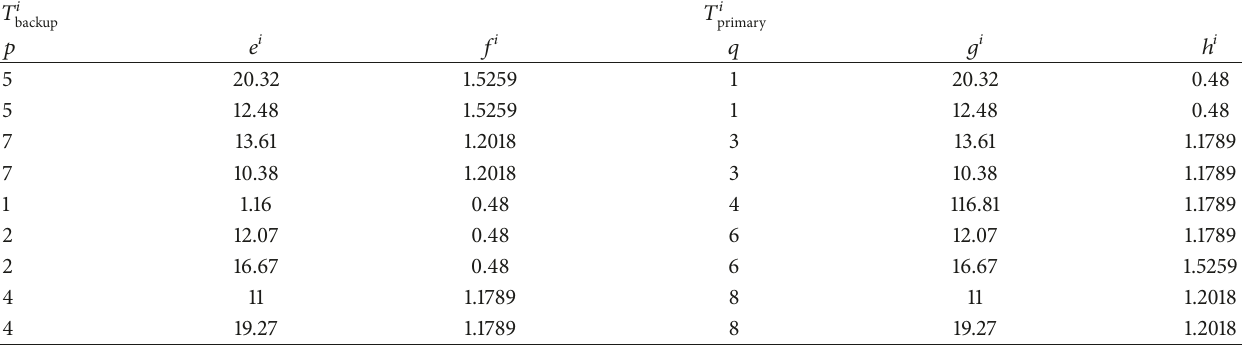
Table 10: Values of constants 𝑒 𝑖 , 𝑓 𝑖 ,𝑔 𝑖 , and ℎ 𝑖 for Model II.